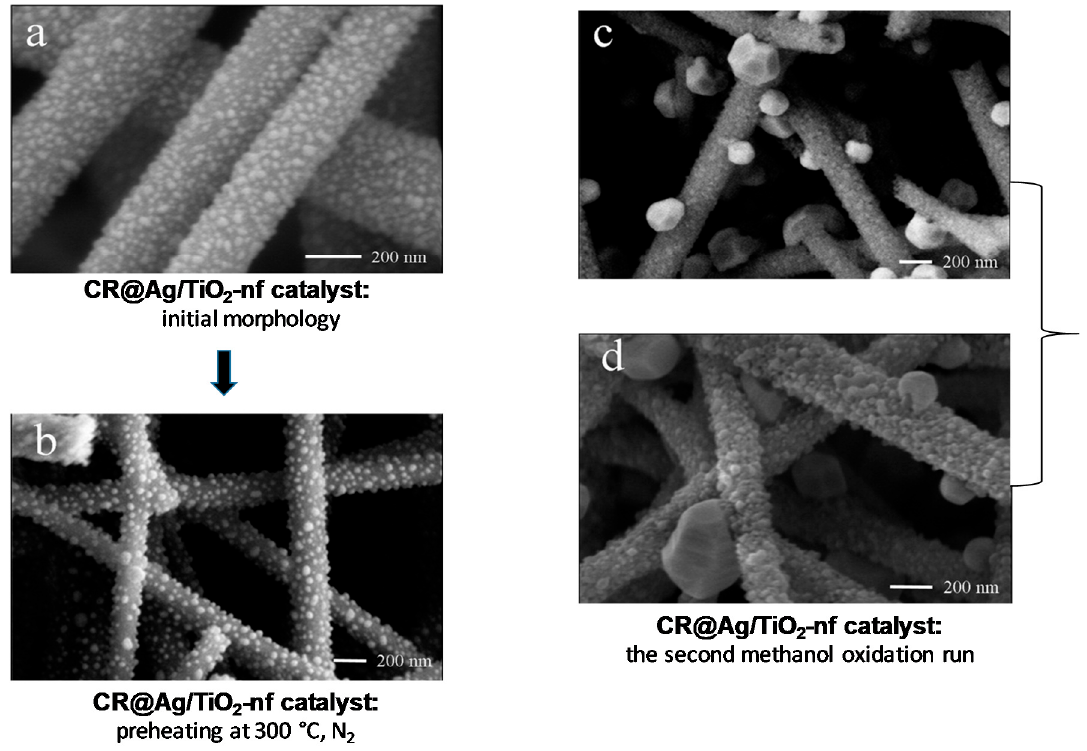
Figure 2. Morphology of 1.00%CR@Ag / TiO 2 -nf catalyst: ( a ) initial morphology; ( b ) after preheating at 300 ◦ C under N 2 ; ( c , d ) after the second methanol oxidation run. [Reprinted from Ref. [27], copyright (2013) with kind permission from American Chemical Society].